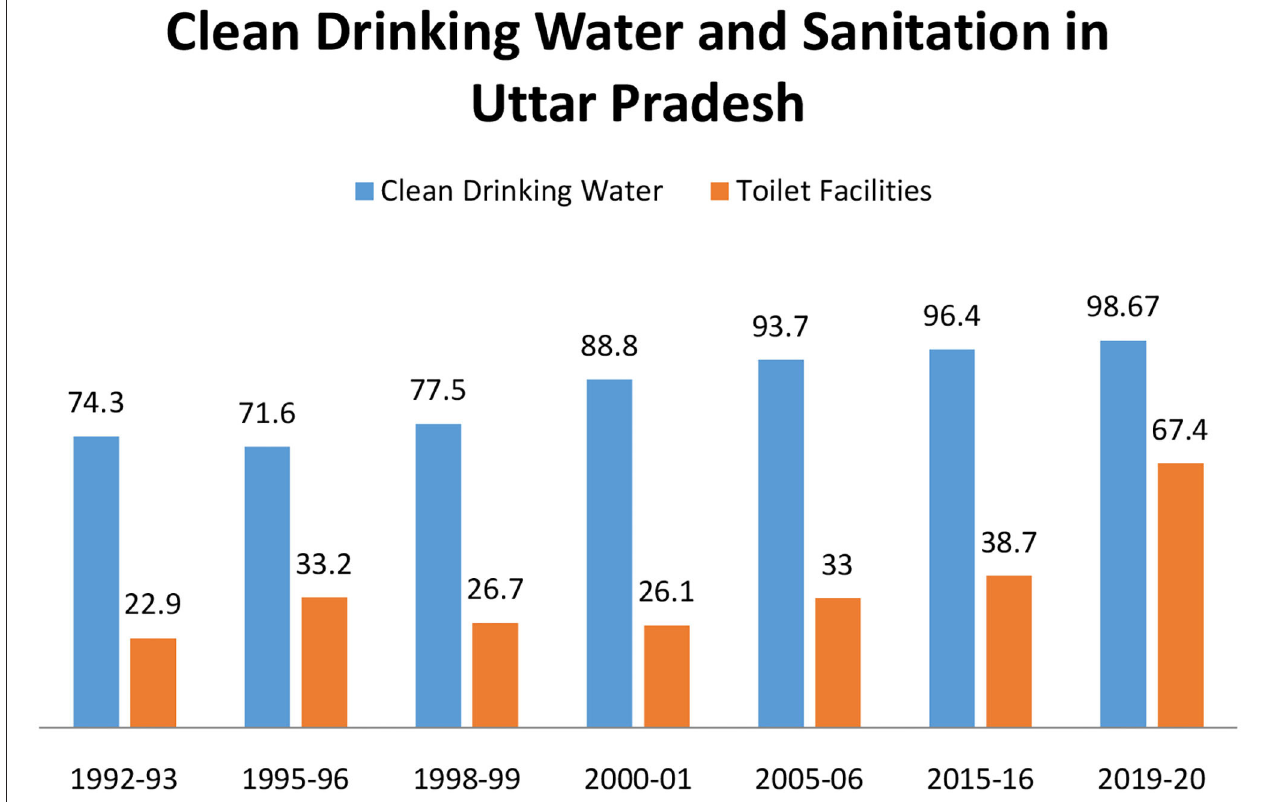
FIGURE 6 | Graphical representation of status of clean drinking water and sanitation facilities in UP during 1992 and 2020. From the graph, it is evident that availability of clean drinking water and sanitation facilities has improved in the state in the past few years.